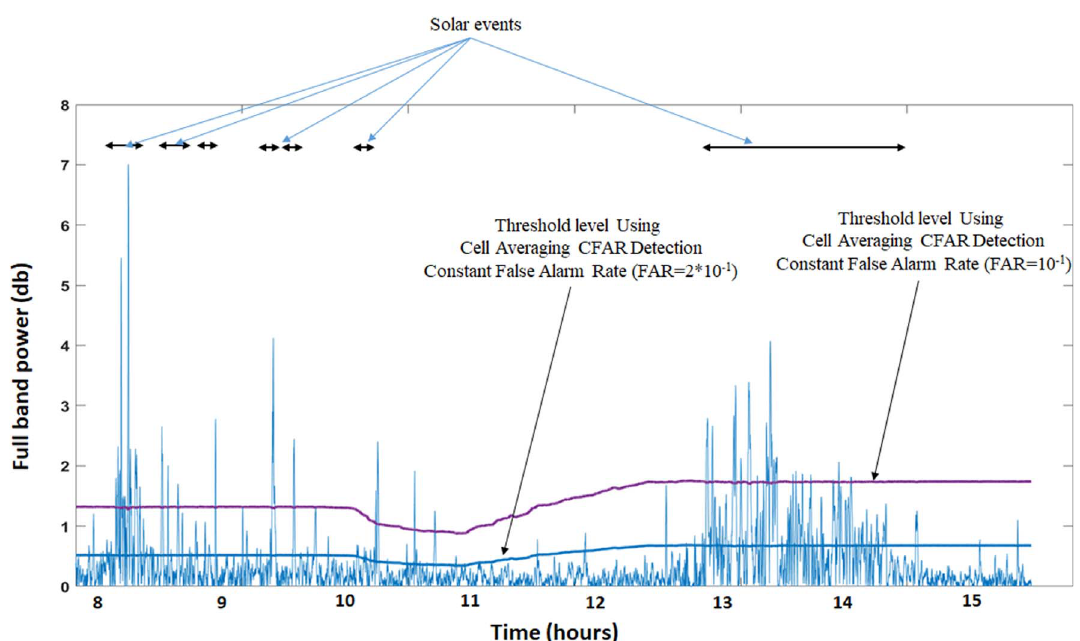
Fig. 14. Comparing the threshold curves obtained by the cell averaging CFAR detector (with two different desired false alarm rate).